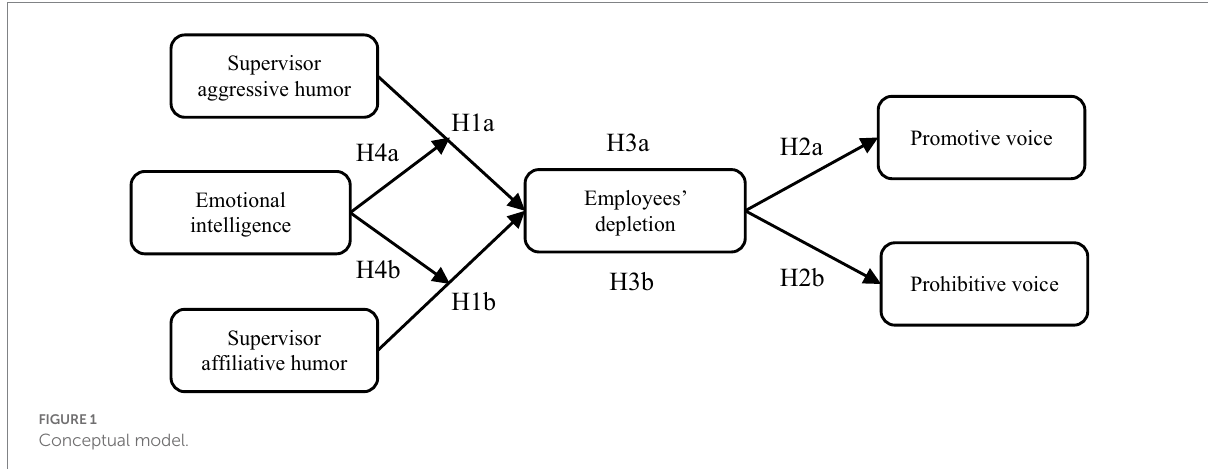
FIGURE 1 Conceptual